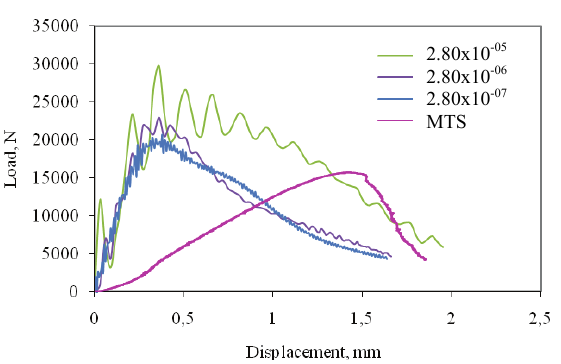
Figure 10: The load-crack extension response at different mass density and the comparison with the experimental data. Figure 9 The load-Displacement values at the different mass density and comparison with the experimental data. Figure 10. The load-crack extension response at different mass Figure 9. The load-Displacement values at the different mass den- 4.3 Sensitivity of Maximum Strength density and the comparison with the experimental data. sity and comparison with the experimental data. The maximum strength is denoted by the strength of two adjacent cohesive elements of the specimen. It is needed to overcome the maximum strength to propagate the crack. To evaluate the material response, three different sets (800MPa, 700MPa, 600MPa) of data were used. Figures 11 and 12 show the load-displacement and the load-crack extension response respectively in Arcan specimen in mode-I.. In that case, other surrounding area was damaged. On the other hand, due parameters were constant. The maximum displacement jump was used as 0.12, the loading velocity 0.6x10 +02 mm/sec, whereas in the experimental case the loading velocity was 0.6x10 -03 mm/sec. Thus in the simulation, the loading velocity was increased by 10 to the high scaling rate the material couldn’t damage its times. The mass density was used as 2.80x10 -05 ton/mm 3 , whereas the original value of the mass density was 2.80x10 -09 ton/mm surrounding area properly before the crack extension. The The mass density increased by 10 4 times in the simulation. The crack length of 16.58 mm was observed. crack initiation and the final failure were occurred at an earlier time with smaller displacement in comparison with the real case.